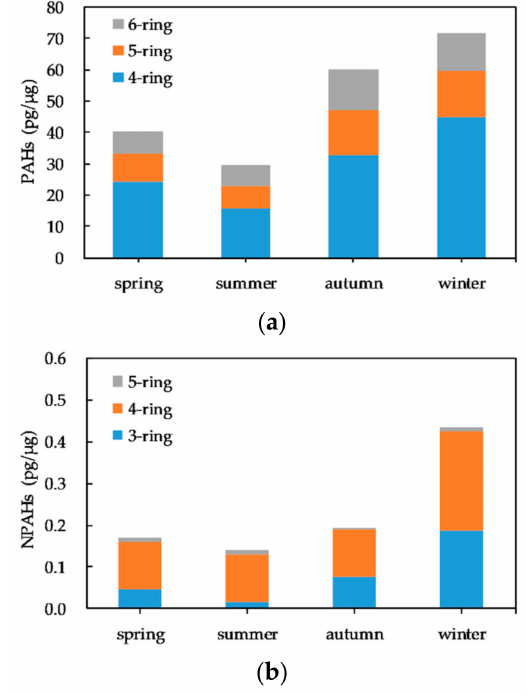
Figure 4. The seasonal variability in the composition of PAHs and NPAHs in PM 2.5 on the basis of the number of rings: ( a ) PAHs; ( b )NPAHs. 4-ring PAHs: Flt, Pyr, BaA, Chr; 5-ring PAHs: BbF, BkF, BaP; 6-ring PAHs: BgPe, IDP; 3-ring NPAHs: 9-NA, 3-NPhe; 4-ring NPAHs: 1-NP, 7-NBaA; 5-ring NPAHs: